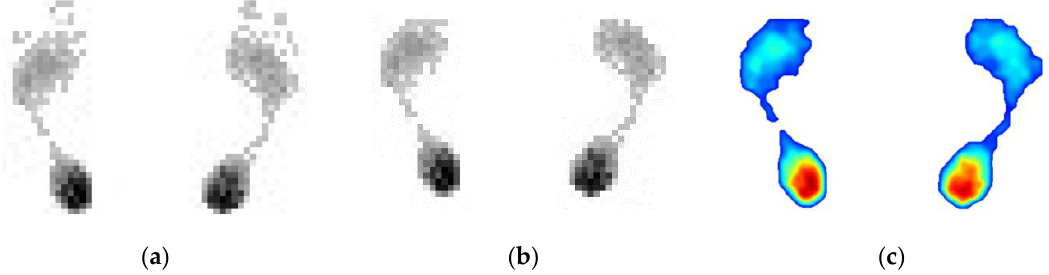
Figure 10. The results of automatic processing based on the proposed method for the high arch feet. ( a ) is the original plantar pressure image of the high arch feet, ( b ) is result after using the proposed method and ( c ) is the interpolation color image of ( b ).